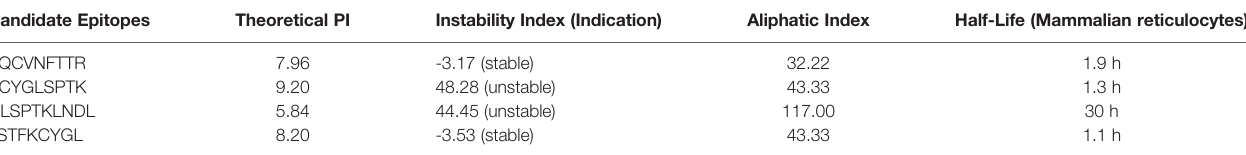
Theoretical PI, theoretical isoelectric